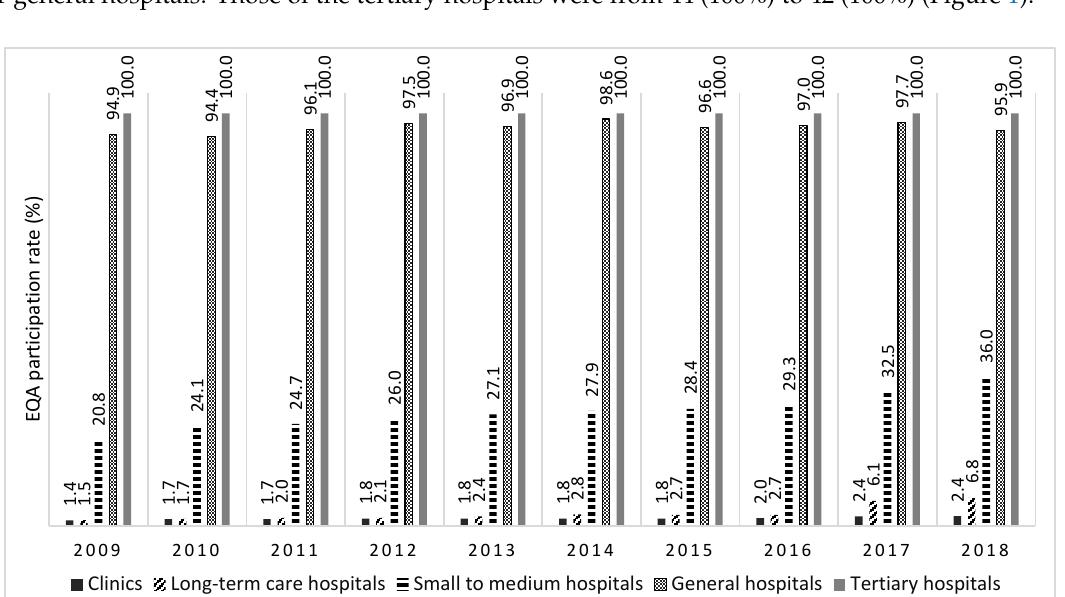
Figure 1. EQA participation rate of medical institutions with claims of laboratory testing for the 10 years (2009 – 2018).